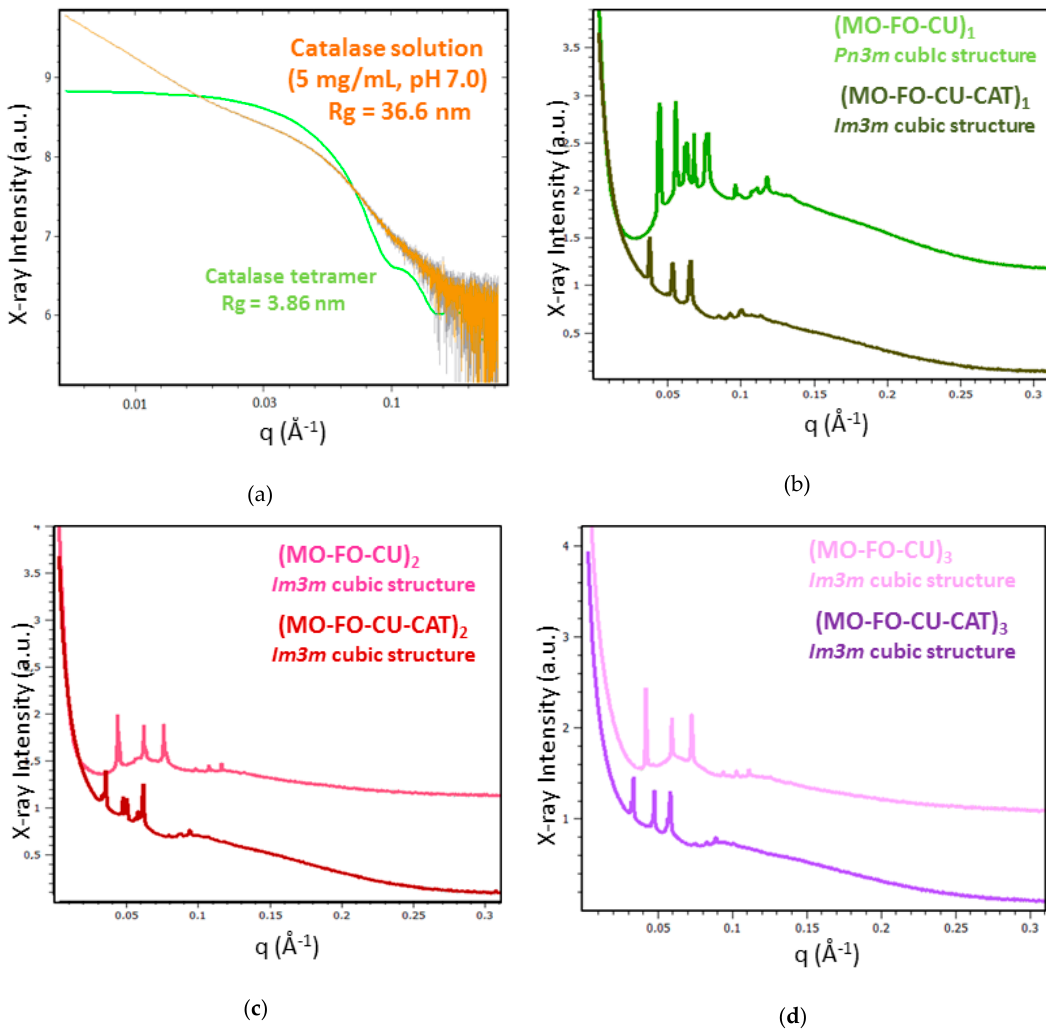
Figure 5. BioSAXS patterns of ( a ) catalase solution (5 mg/mL) in 0.01 M of phosphate buffer, and ( b–d ) liquid crystalline nanoparticle dispersions obtained in the presence or absence of catalase (CAT) at varying fish oil (FO)/monoolein (MO) ratios (wt%/wt%): ( b ) 20:80 (MO-FO-CU) 1 vs. (MO-FO-CU-CAT) 1 ; ( c ) 40:60 (MO-FO-CU) 2 vs. (MO-FO-CU-CAT) 2 ; and ( d ) 60:40 (MO-FO-CU) 3 vs. (MO-FO-CU-CAT) 3 . The percentages of curcumin (CU) and TPE G1000 are constant with regards to MO and FO (see the compositions in sections 4.3 of Methods Temperature is 22 °C.